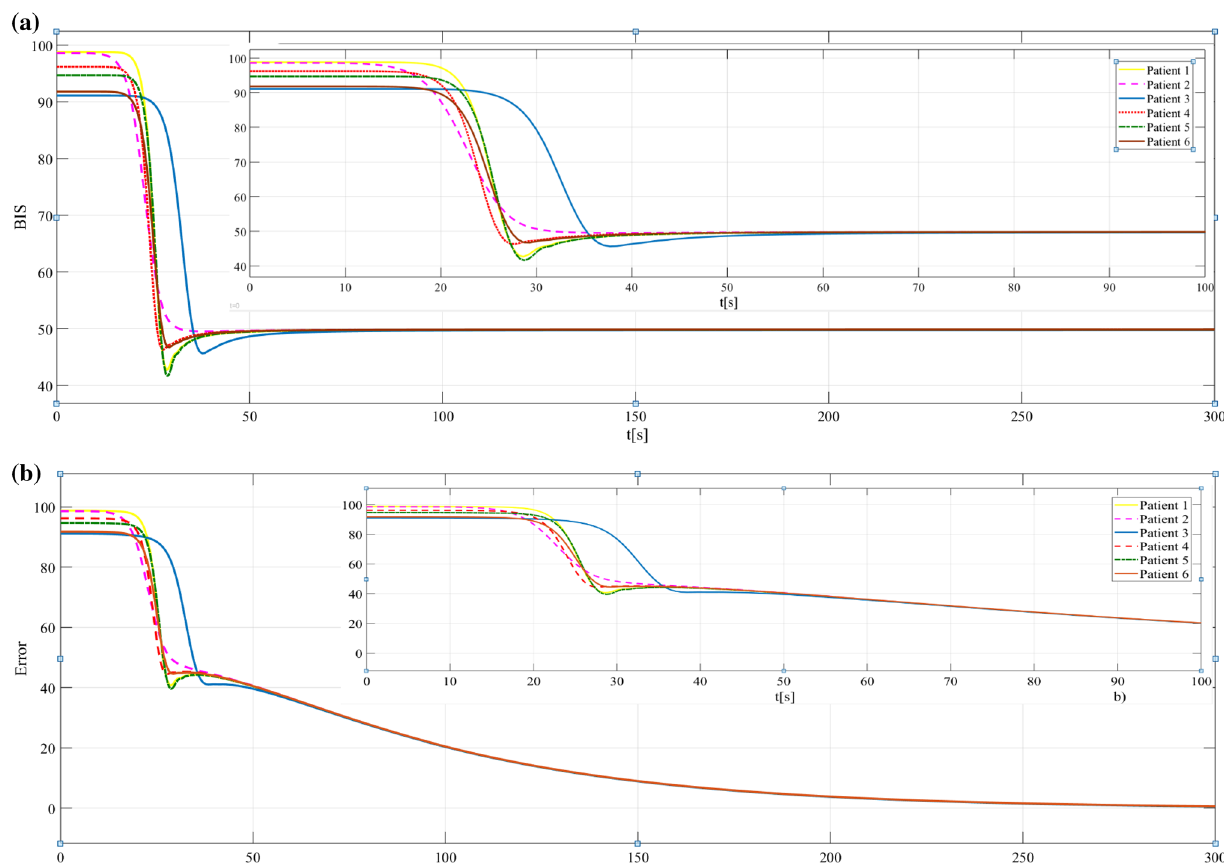
Fig. 5 a BIS response for each patient (PI controller); b The error (PI